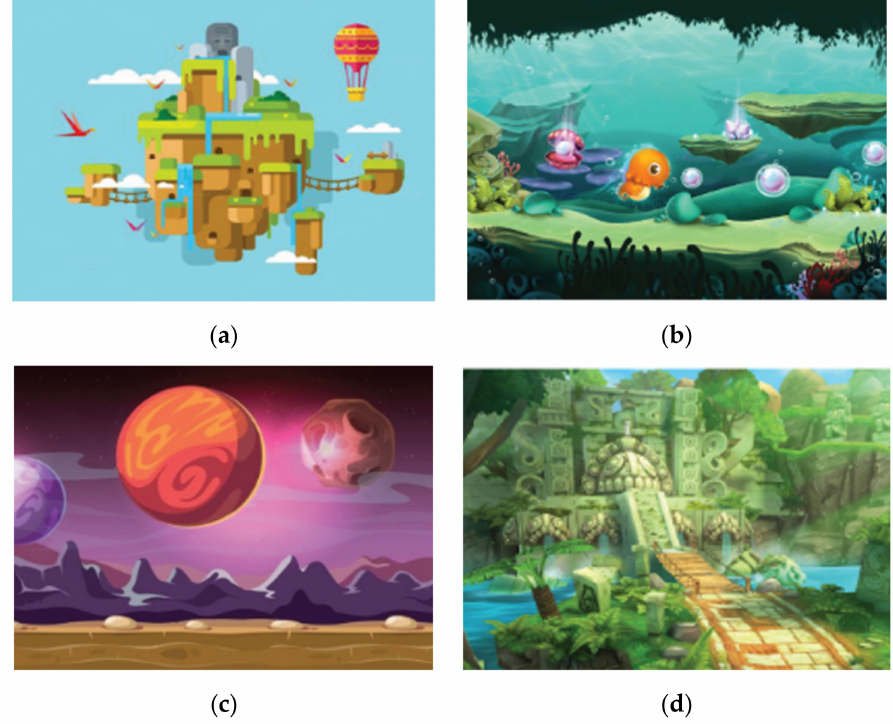
Figure 7. Game settings proposed to the parents among which they had to select the most attractive for their children: ( a ) the sky, ( b ) the seabed, ( c ) space, and ( d ) the